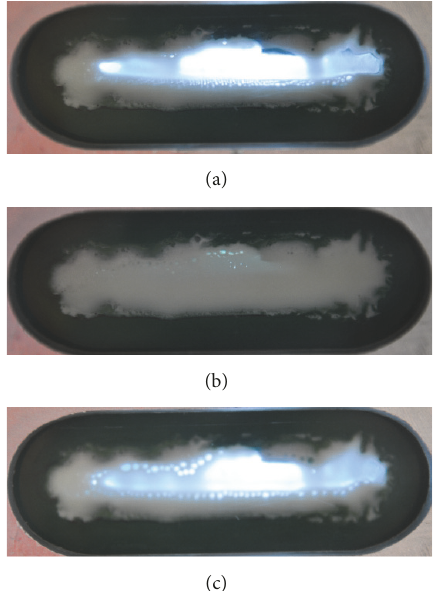
Figure 4: Photos of slug flow: (a) liquid film zone before liquid slug, (b) liquid slug, and (c) liquid film zone after liquid slug.